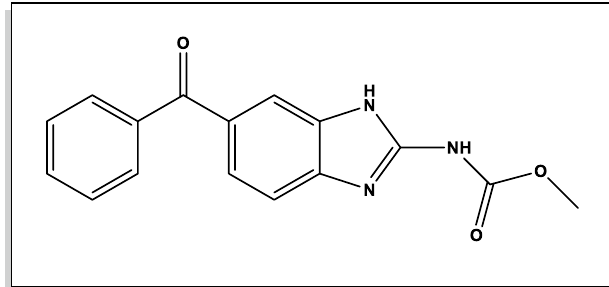
Figure 1. Structural formula of Mebendazole